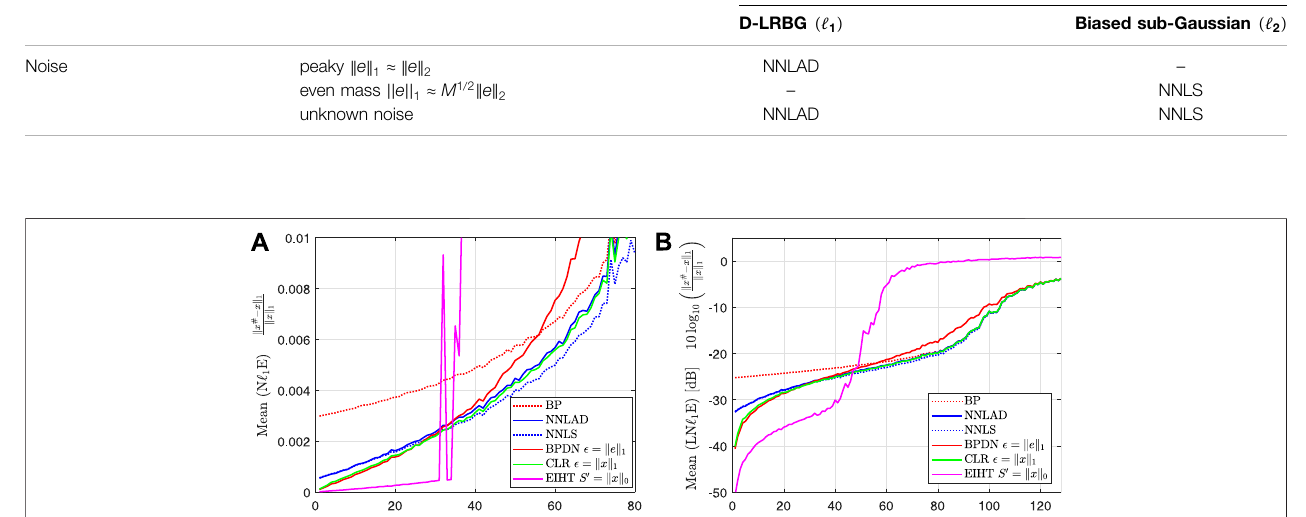
FIGURE1| PerformanceofNNLADfornoisewithevenmassnoiseandvaryingsparsityofthesignal. (A) NNLADhasalmostthesameperformanceasCLR/BPDN. EIHT fails for moderate S . (B) NNLAD and NNLS perform roughly the same.